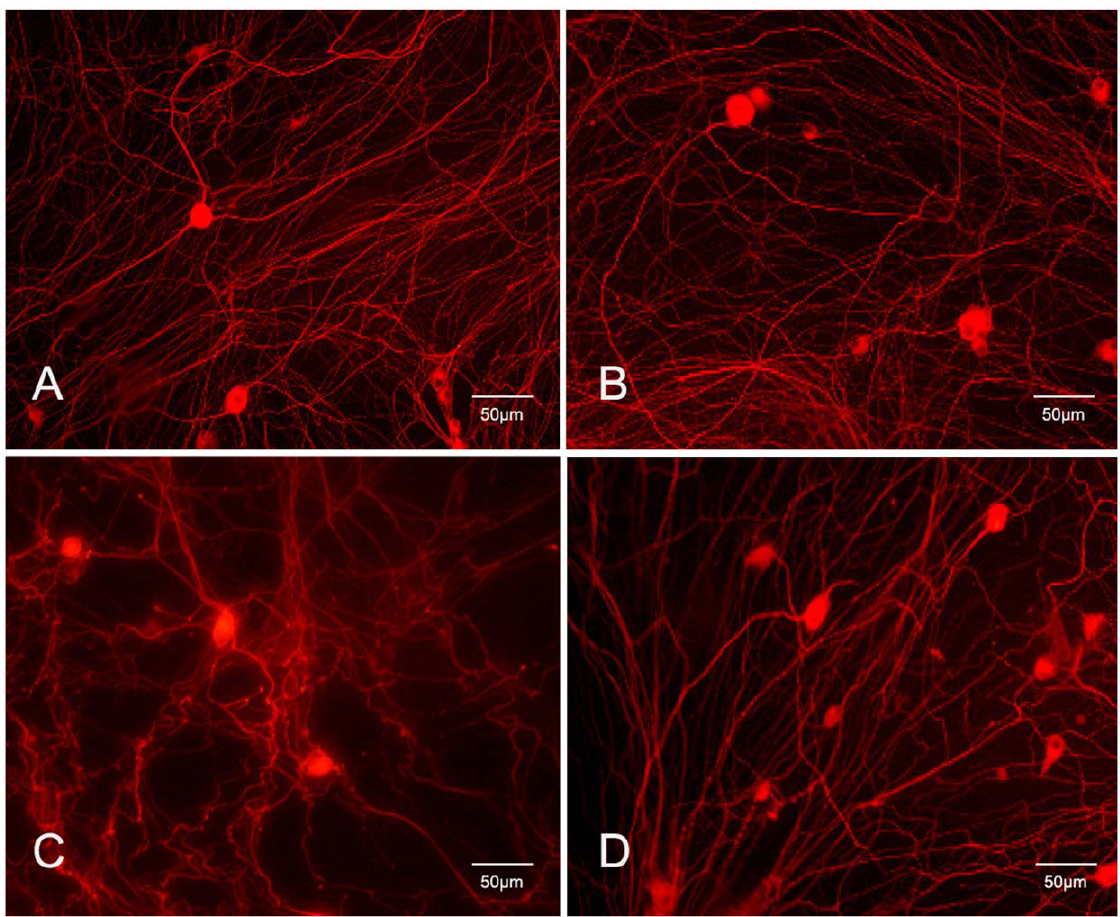
Figure 4. Effects of mechanical pressure on microtubules in DRG neurons b III-tubulin. The expression of b III-tubulin was mainly localized in the cytoplasm. There were no significant changes in control cells (A) or control + PD150606–treated cells over time (B). Cells subjected to 0.5 MPa of pressure for 30 min (C) showed retraction or collapse of neurites, coincident with a decrease in the expression of b III-tubulin. However, in cells subjected to 0.5 MPa of pressure and treatment with PD150606 (D), the collapse of neurites as indicated by decreased b III-tubulin was reduced, and b III-tubulinexpression was significantly higher when compared with cells treated with 0.5 MPa of pressure without PD150606. All experiments were repeated at least three times.